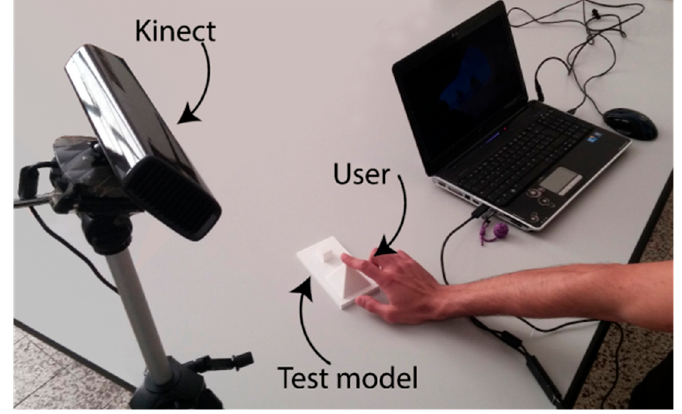
Figure 6. Hardware for the test of touch identification.